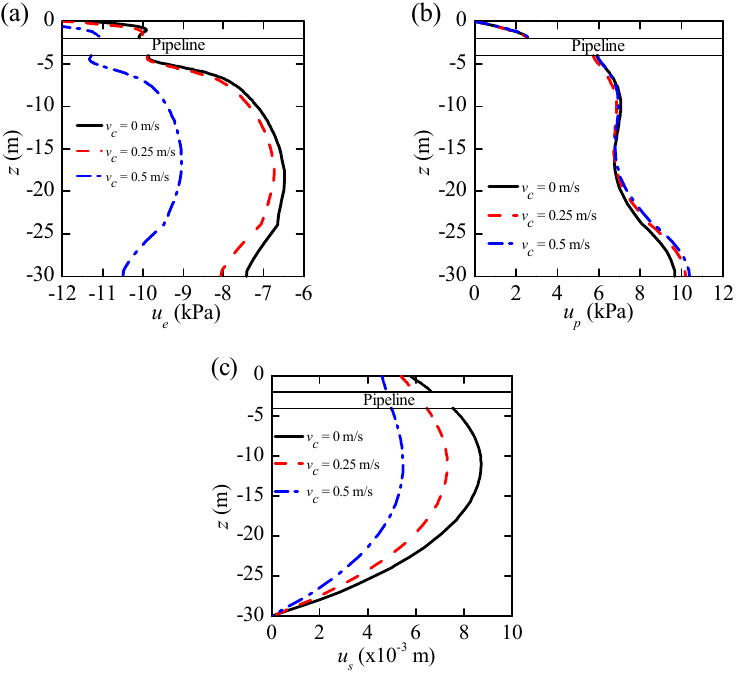
Figure 7. Variation in ( a ) oscillatory pore pressure, 𝑢 (cid:3032) , ( b ) residual pore pressure, 𝑢 (cid:3043) and ( c ) displacement, 𝑢 (cid:3046) under various current